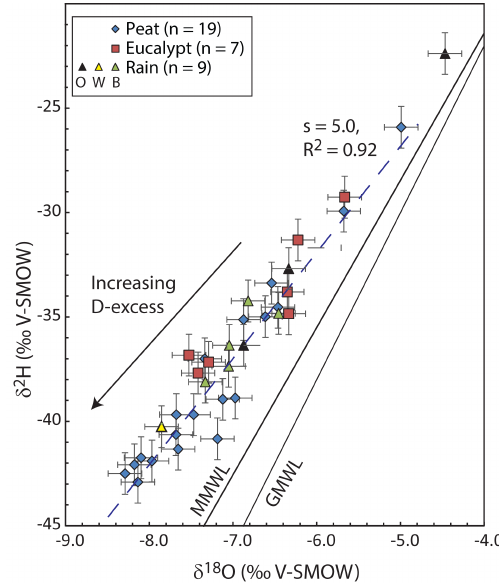
Figure 4. 3 H activities vs. δ 2 H values of waters from the Australian Alps (data from Table 1). Error bars are analytical uncertainties (1‰ for δ 2 H and 3 H from Table 1). Rainfall samples: B indicates Mount Buffalo multi-month samples; W indicates the 2-week win- ter precipitation sample; O indicates other samples from southeast Australia. Linear regression line is fit to the multi-month Mount Buffalo samples. Arrowed lines show changes in 3 H activities and δ 2 H values due to evaporation (evap) and radioactive decay of 3